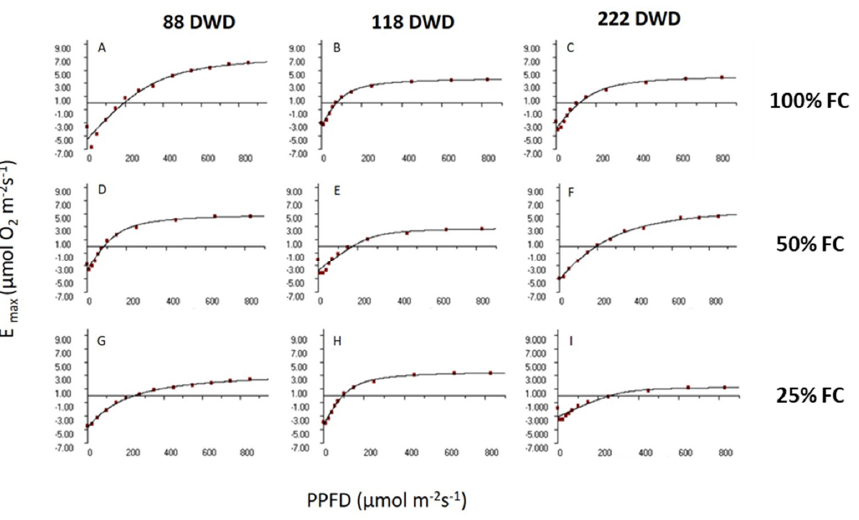
Figure 4. Light-responses curves for the rate of photosynthetic oxygen evolution of A. vera plants, previously preconditioned at 100 (A, B, C), 50 (D, E, F), and 25 (G, H, I) % of FC, at different intervals of time during the water deprivation experiment.